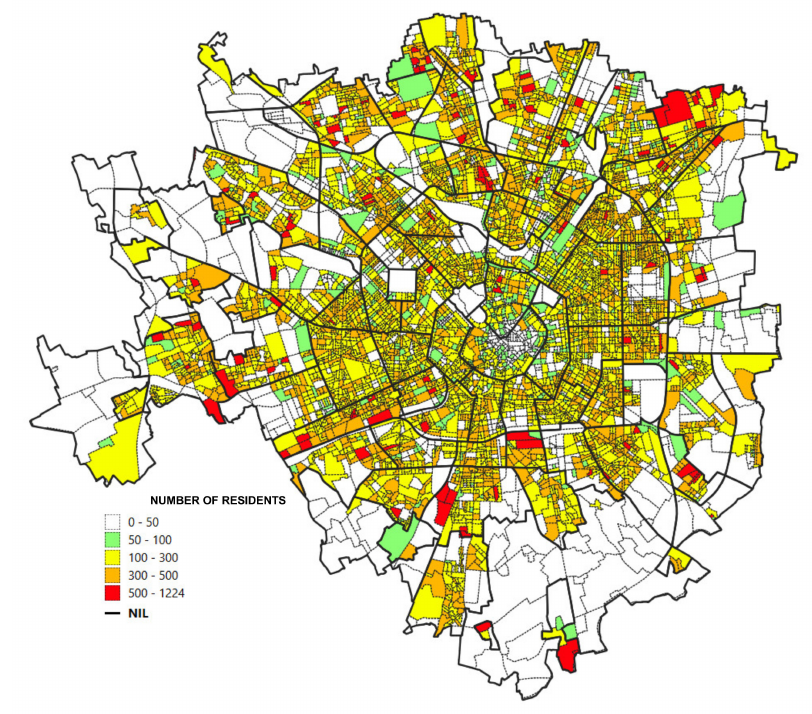
Figure 6. View of the census tracts and